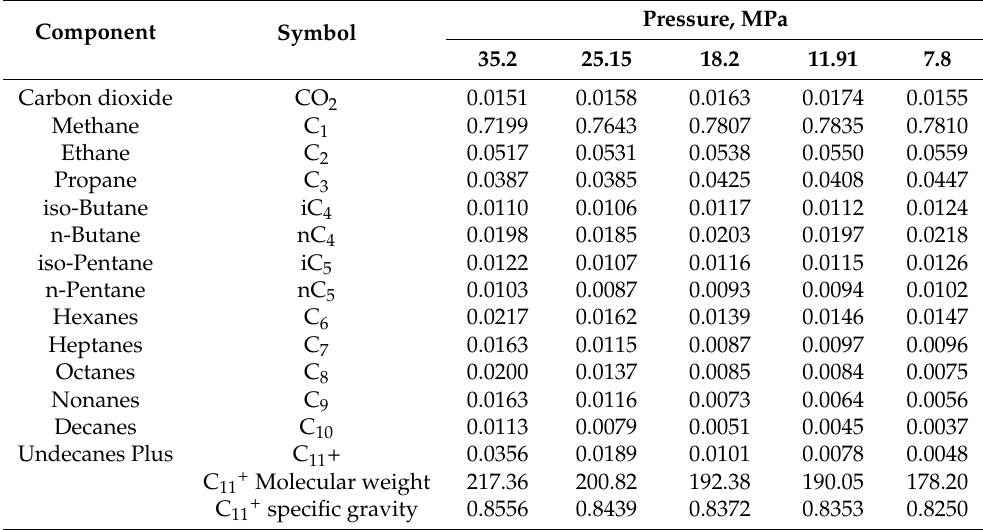
Table 1. Experimental data of constant volume depletion (mole fraction of different